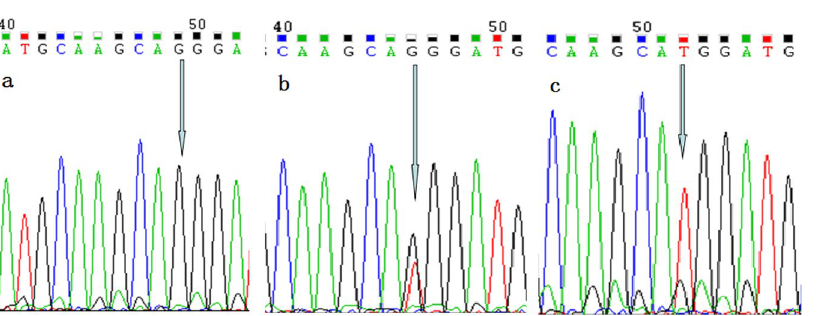
Figure 1. Sequencing map of the genotype for the TNFR2 rs1061622 polymorphism. Arrow in parts ( a – c ) indicates GG, G/T and TT genotypes, respectively.